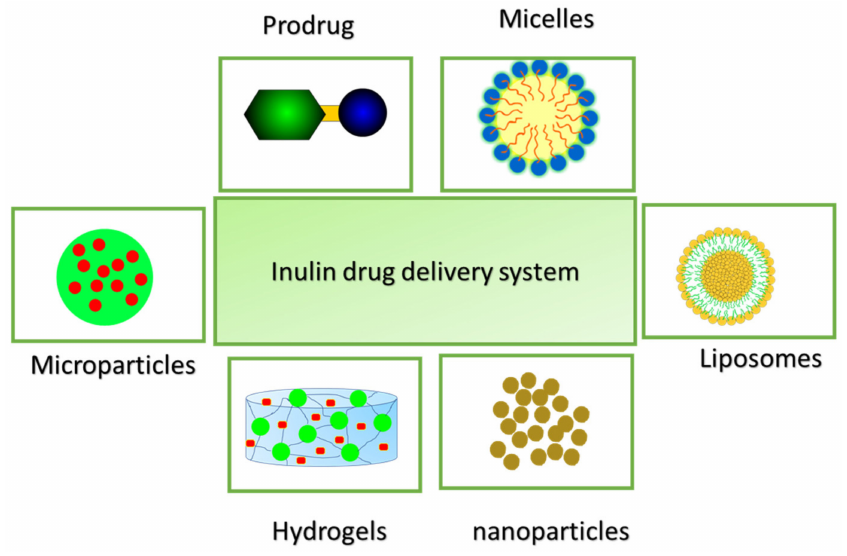
Figure 2. Inulin drug delivery